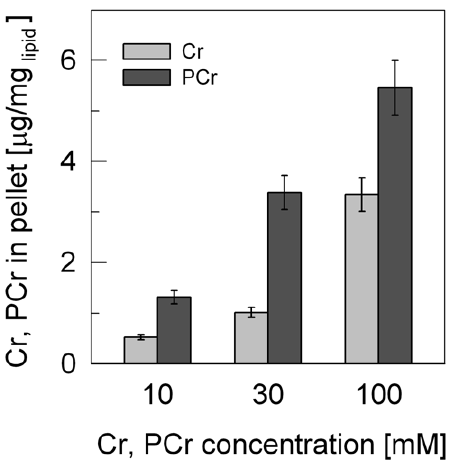
Figure 1. Phosphocreatine and creatine are retained by liposomes as determined in a biochemical assay. LUVs consisting of phosphatidylcholine and cardiolipin (PC/CL) were incubated either with Cr or PCr at different concentrations in TES buffer (10 mM pH 7.0, 50 mM NaCl), centrifuged, the pellet washed twice, and remaining Cr and PCr quantified. Data are given as mean 6 SD